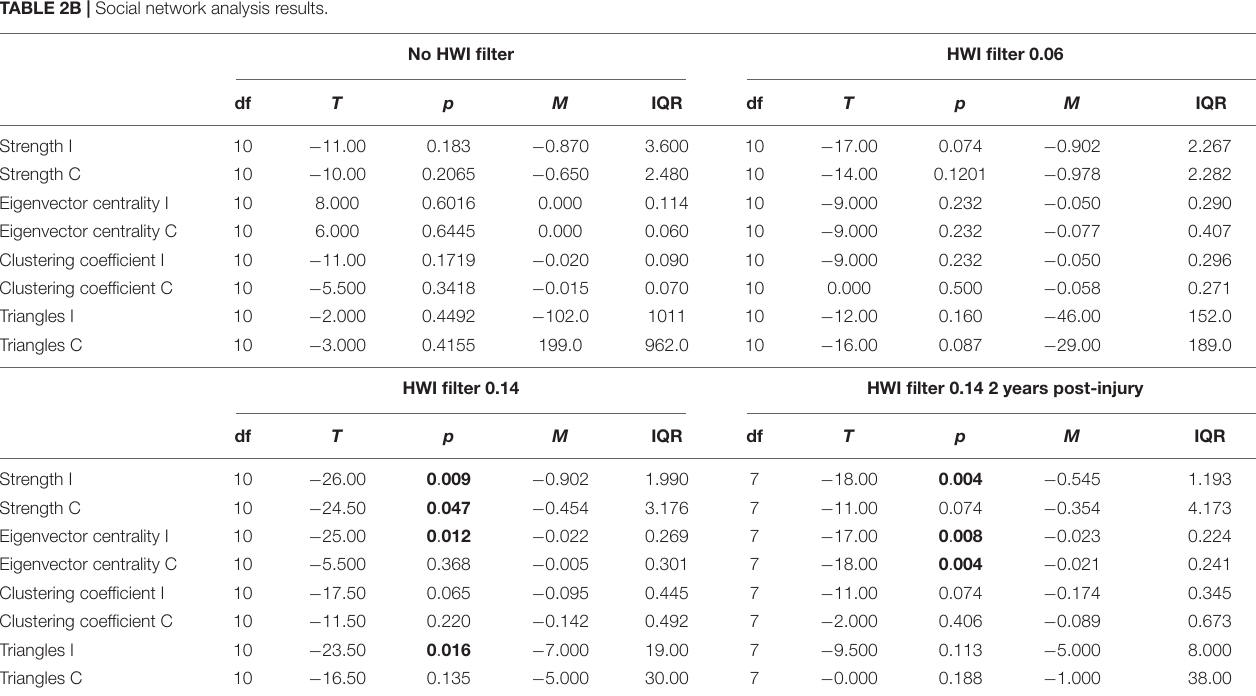
TABLE 2B | Social network analysis